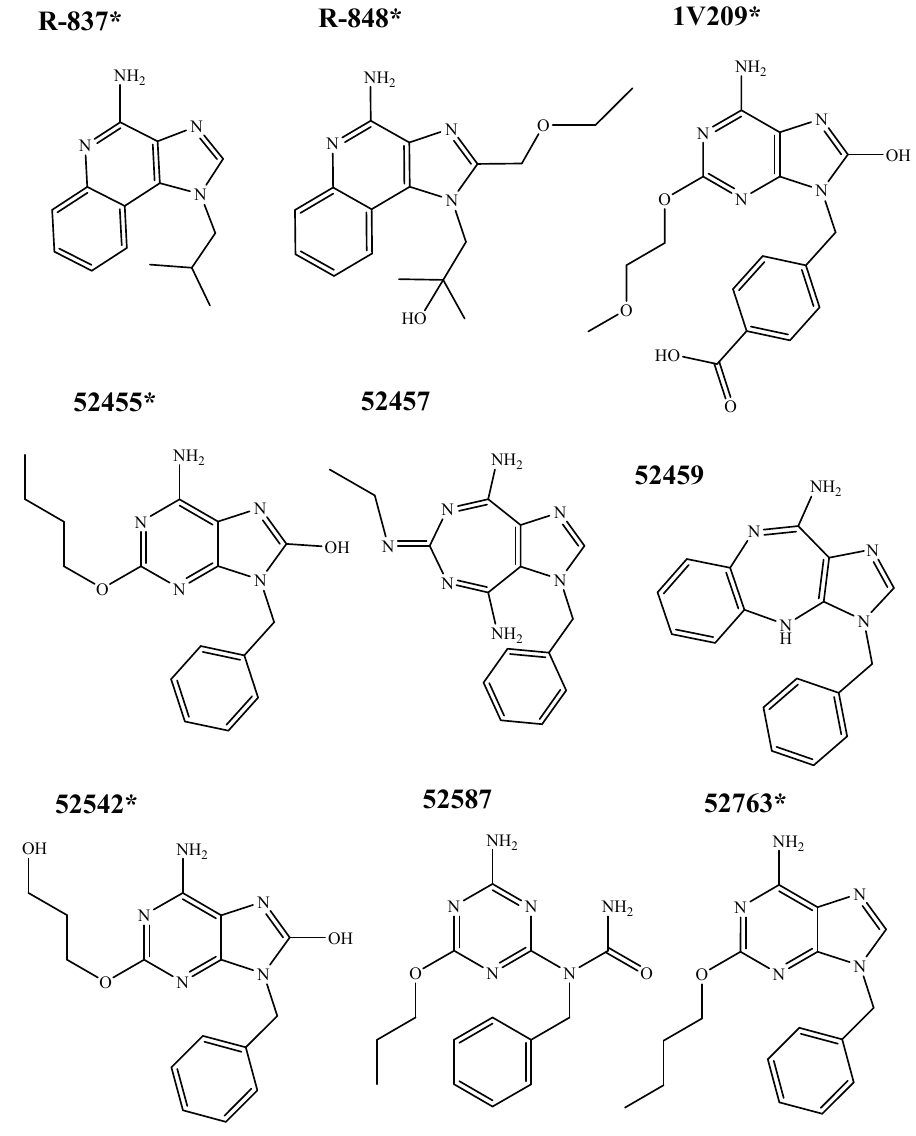
Figure 10. Chemical structures of tested imidazoquinoline and adenine derivatives. * indicates the TLR7